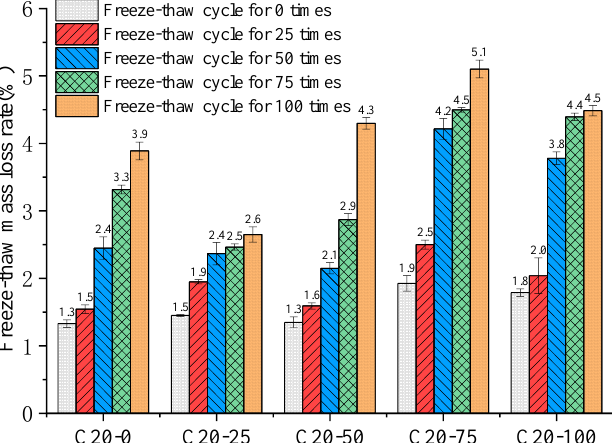
Figure 15. Water absorption of C20 concrete under freeze–thaw cycles. 5. Mass loss The quality loss of C20 concrete with different proportions of wastewater replacing potable water under freeze–thaw cycles is shown in Figure 16. With the increase in the proportion of wastewater as a replacement for potable water, the quality loss of C20 concrete first decreases, then increases, and then decreases again. With the increase in freeze–thaw times, the quality loss of C20 concrete with different proportions of wastewater replacing potable water gradually decreased. C20-25 has better frost resistance than C20-0 after 100 freeze–thaw cycles, and the corresponding mass loss decreases by 47.3%, whereas C20-50, C20-75, and C20-100 exhibited worse performance (the mass loss increases by 29.0%, 15.1%, and 25.3%, respectively).